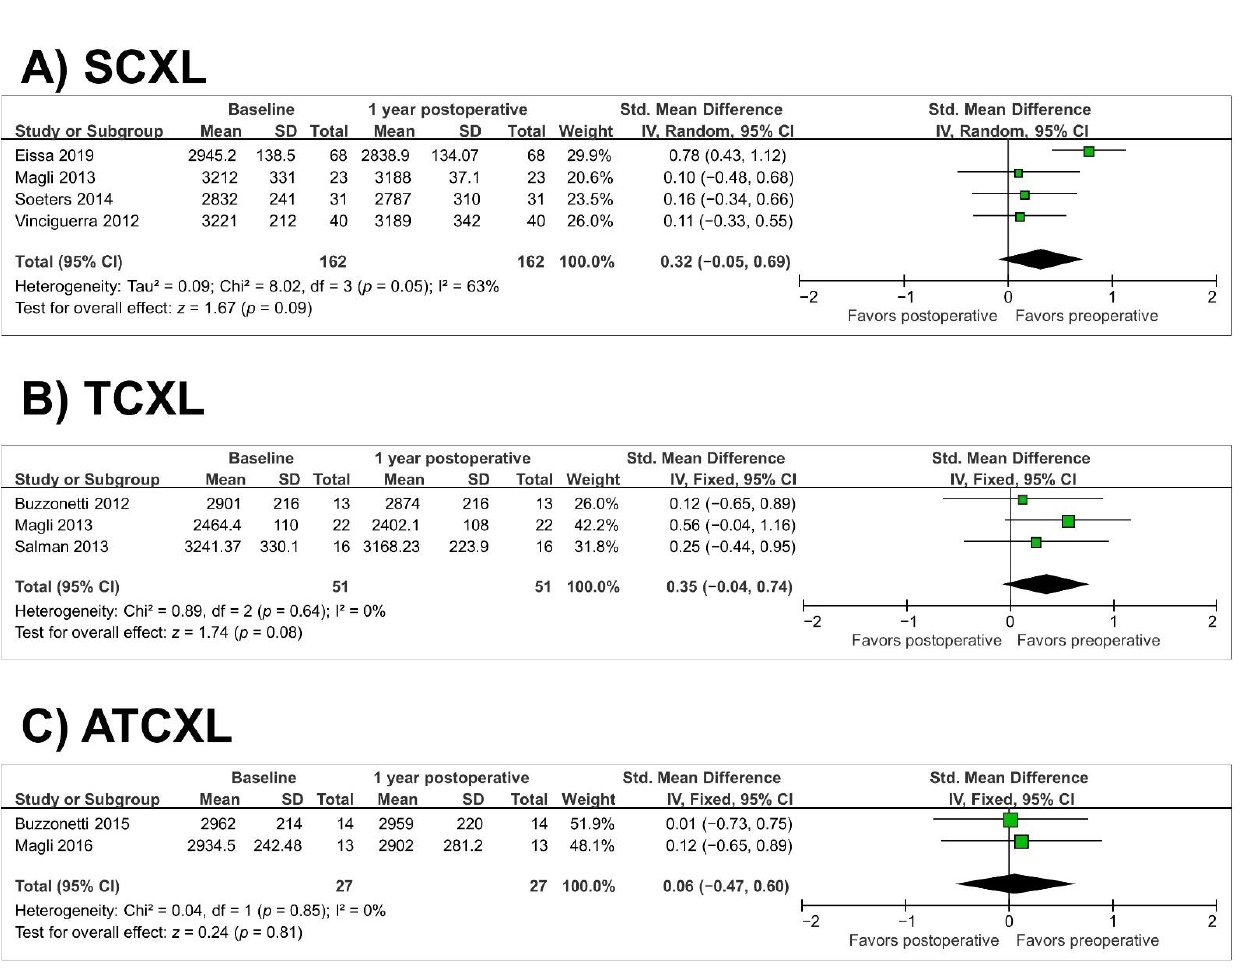
Figure 8. Forest plot of corneal endothelial cell density 1-year standardized mean differences in cells/mm 2 in studies included in meta-analysis. ( A ), standard cross-linking (SCXL); ( B ), transepithelial CXL (TCXL), ( C ), accelerated and transepithelial CXL (ATCXL). IV = inverse variance, CI = confidence interval, Tau 2 = tau-square statistic, Chi 2 = chi-square statistic, df = degrees of freedom, I 2 = I-square heterogeneity statistic, Z = Z-statistic.Table 2. Summary of complications of CXL after a 1-year followup.